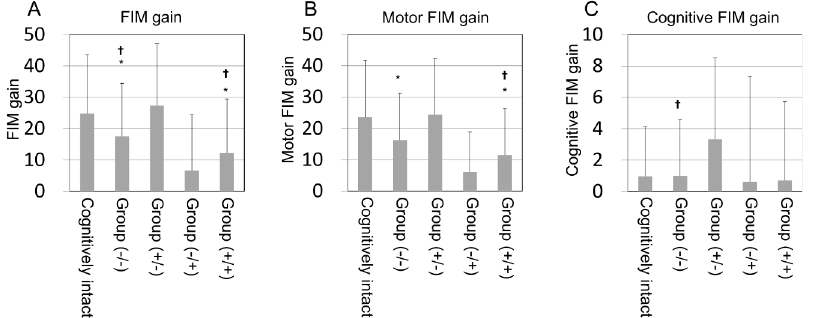
Fig 2. FIM gain among cognitively intact and cognitive impaired groups divided by BPSD. FIM, functional independence measure; data is mean ± standard deviation. Group (-/-): BPSD (-) both at the beginning of and at the end of rehabilitation. Group (+/-): BPSD (+) at the beginning and BPSD (-) at the end of rehabilitation. Group (-/+): BPSD (-) at the beginning of rehabilitation and BPSD (+) at the end of it. Group (+/+): BPSD (+) both at the beginning of and at the end of rehabilitation. Analyzed by ANOVA and Bonferroni as a post-hoc test. (A) FIM gain. (B) motor FIM gain. (C) cognitive FIM gain. (cid:3) vs. cognitively intact; † vs. Group (+/-).